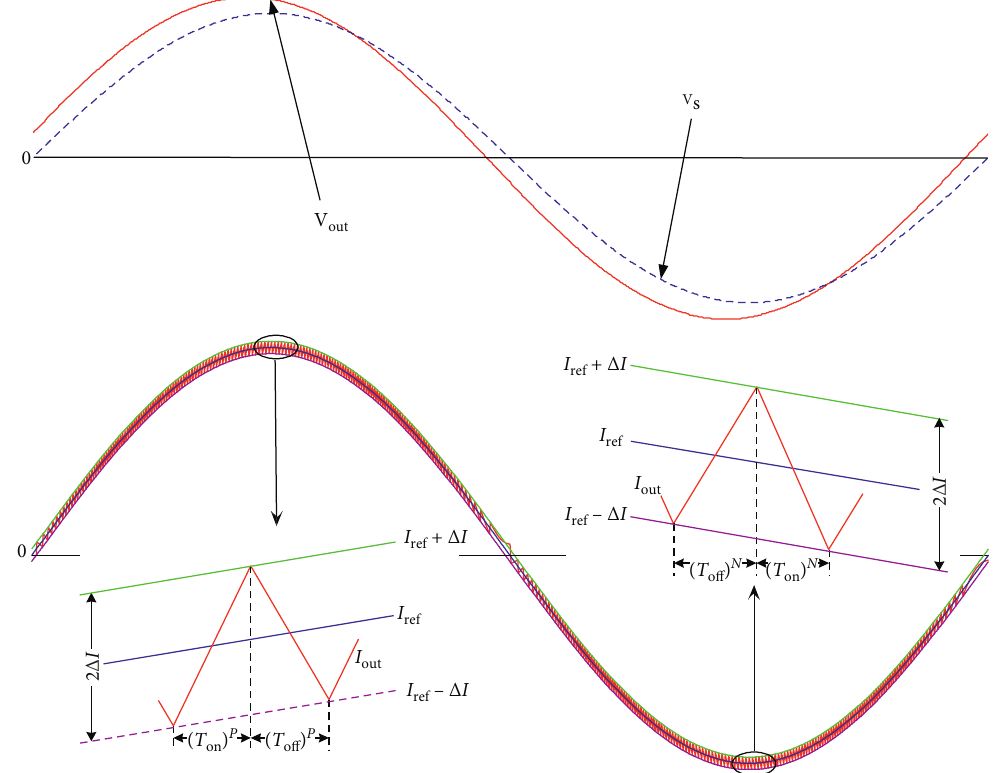
Figure 4: Principle of hysteresis current control